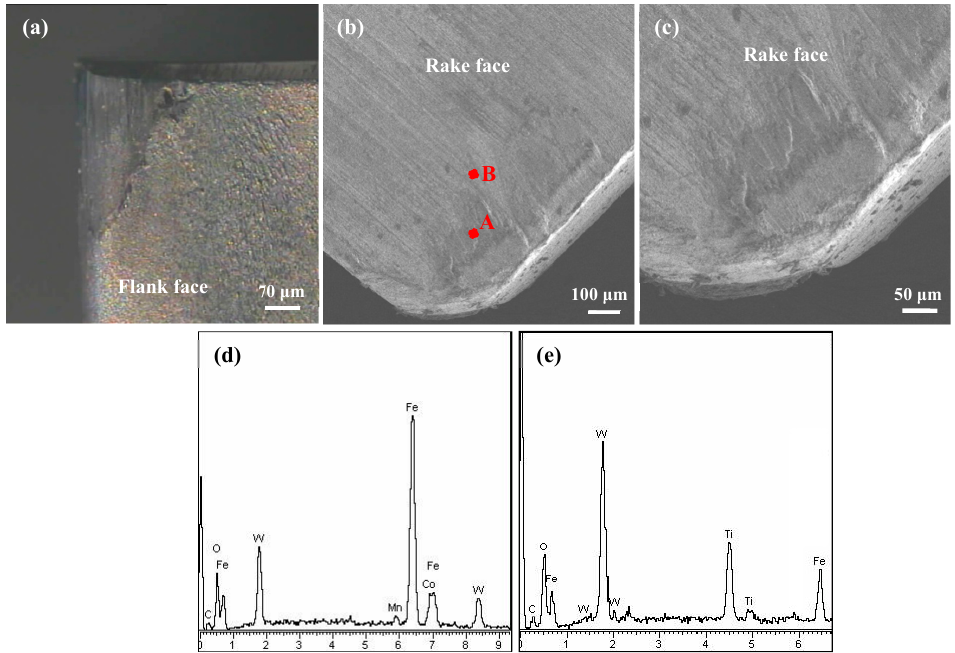
Figure 14. SEM micrographs and EDX component analysis of tool surface of SCT1 after 5 min dry cutting at speed of 100 m/min: ( a ) Micrograph of the worn flank face; ( b ) SEM micrograph of the worn rake face, ( c ) enlarge micrograph corresponding to ( b , d , e ) corresponding EDX component analysis of point A and B in ( b ).